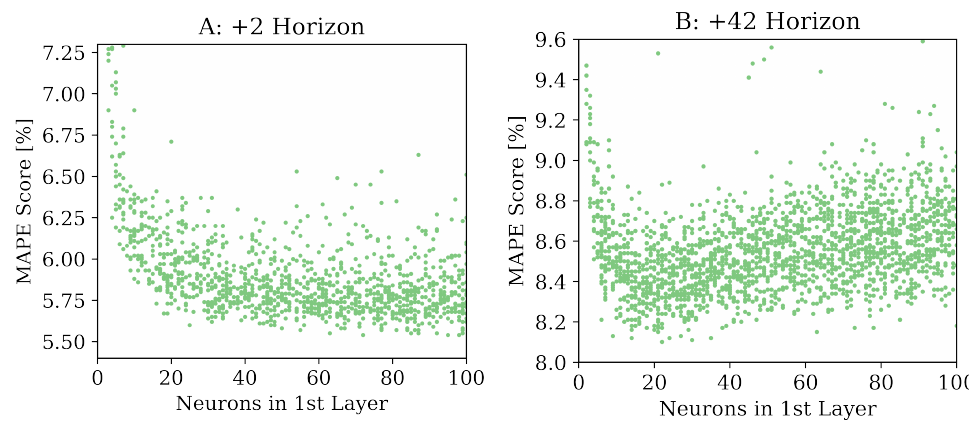
Figure 7. Comparison between the dependency of the model performances on the number of hidden neurons in the first layer for ( A ) a 2 h ahead forecast horizon and ( B ) a 42 h ahead forecast horizon.